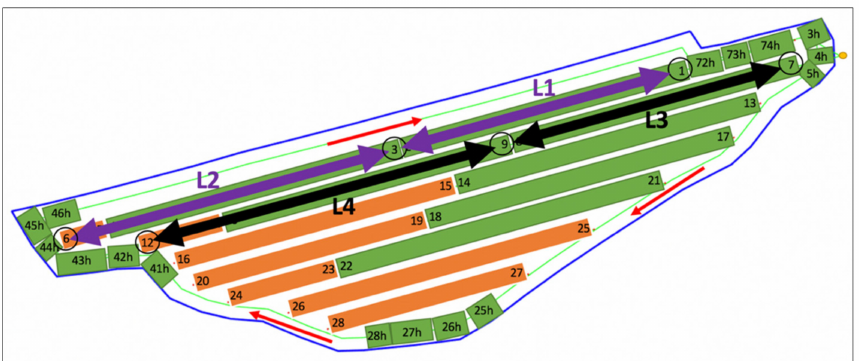
Figure 3. The process of updating the original cost matrix; L1: The distance from node 3 to the head of the first track (node 1); L2: The distance from node 3 to the bottom of the first track (node 6); L3: The distance from node 9 to the head of the second track (node 7); L4: The distance from node 9 to the bottom of the second track (node